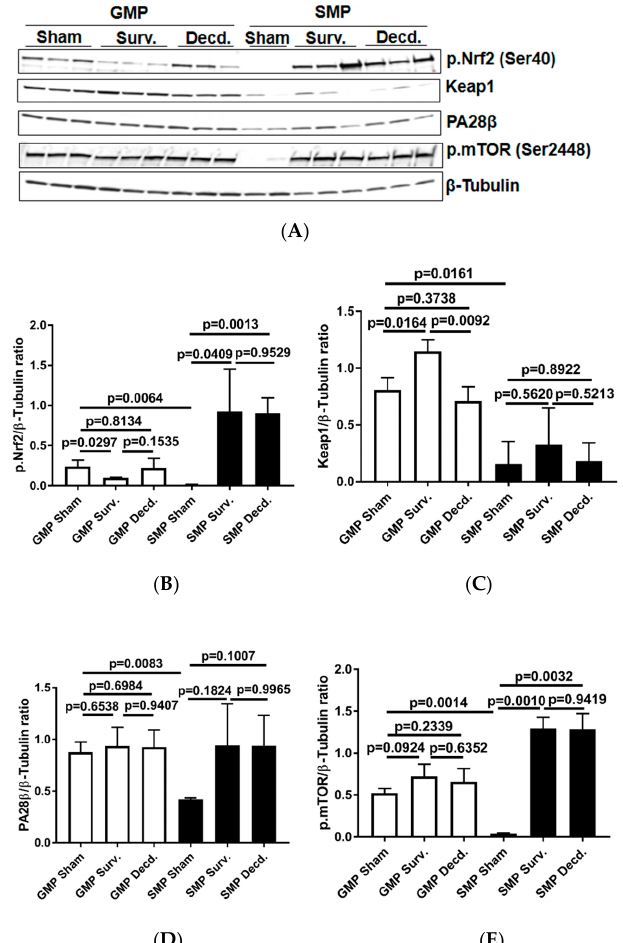
Figure 4. Analysis of nuclear factor erythroid 2–related factor 2 (Nrf2) activation, Keap1, mammalian target of rapamycin (mTOR), and PA28 β in the hearts of sham and irradiated GMP/SMP. ( A ) Western blot analysis of activated Nrf2 (Ser40) transcription factor, Keap1, PA28 β , and phosphorylated mTOR (p.mTOR) in heart lysates of sham and irradiated survivor or decedent GMP/SMP. β -Tubulin is shown as loading control. ( B – E ) Graphs representing the quantification of Western blot analysis of Nrf2 phosphorylation, Keap1, PA28 β , and mTOR phosphorylation in the protein extracts of control and irradiated GMP / SMP animals. Y-axis in each graph shows the normalized ratio of respective Western blot bands to β -Tubulin as loading